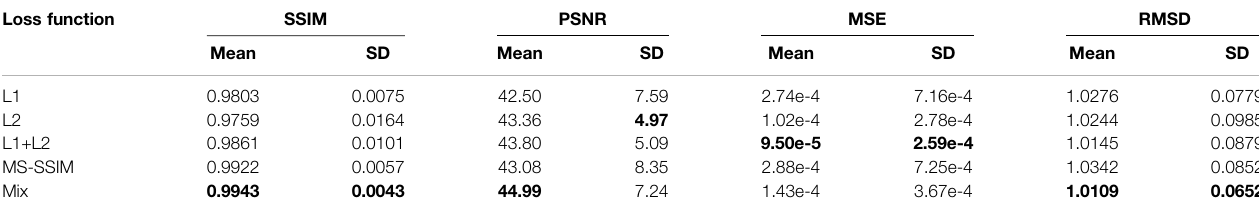
TABLE 6 | Comparison of results of different loss functions. All the results are tested on 20000 images, and then the average and standard deviation are obtained. MSE is calculated after image